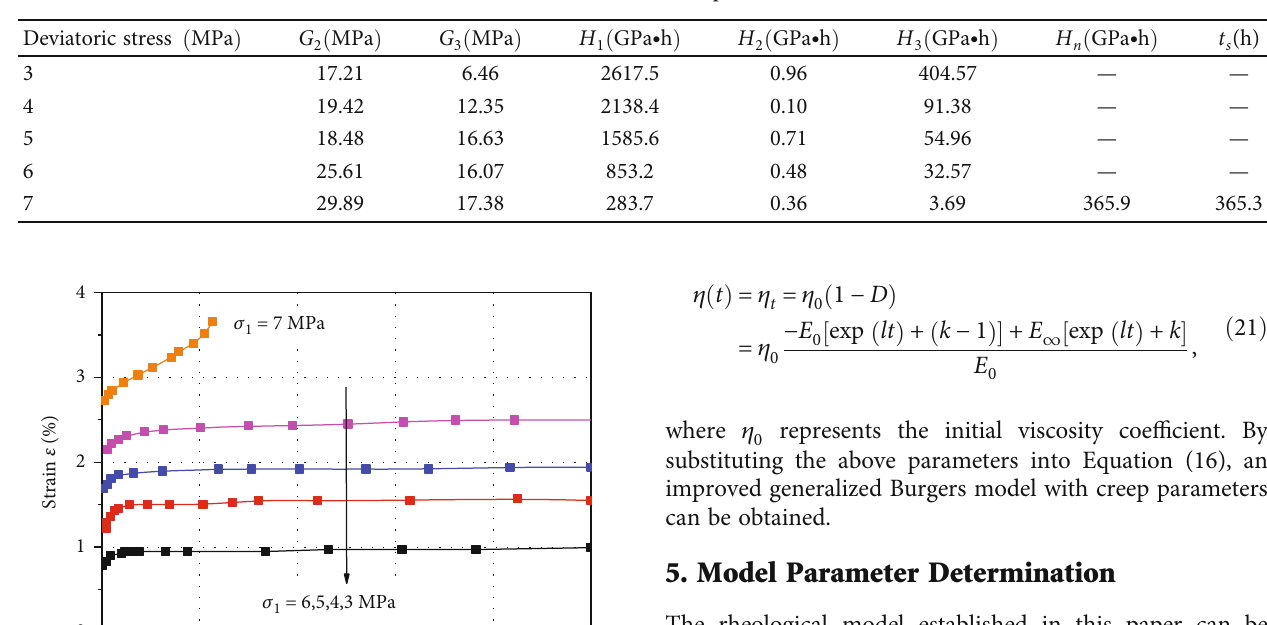
Table 1: Results of model parameters.